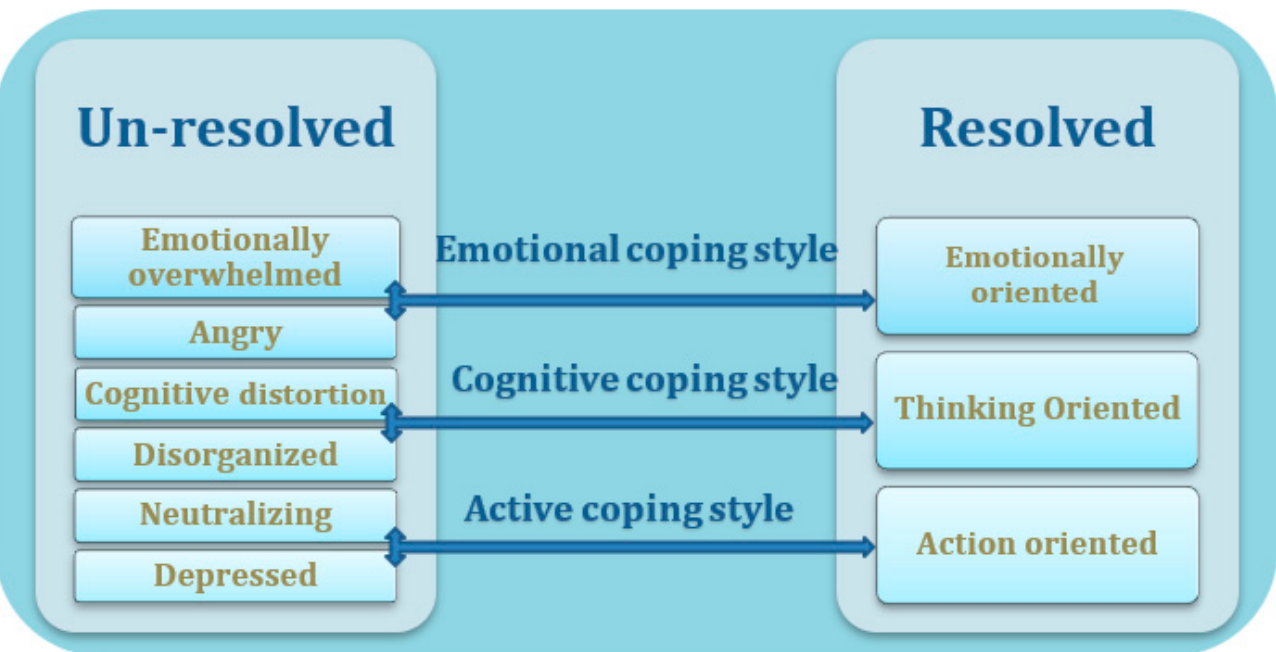
Figure 1. A visual display of the continuum approach to RDI categories.